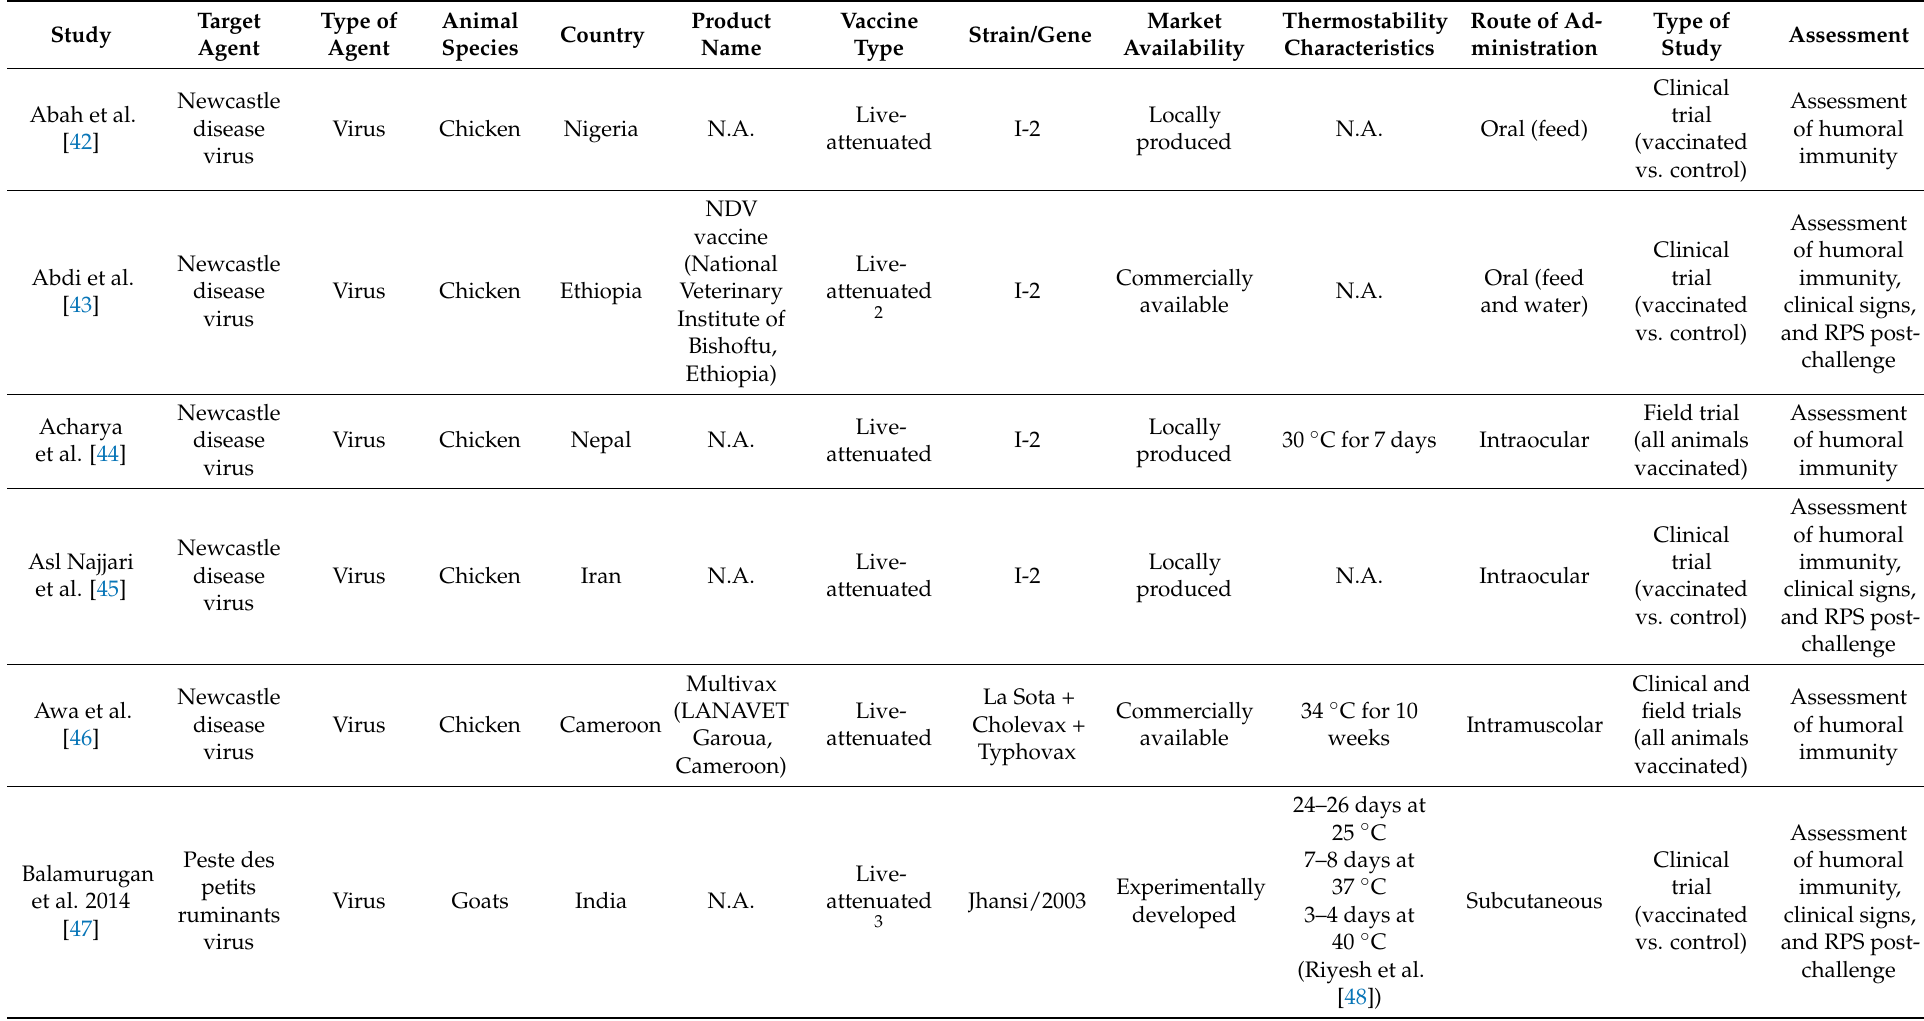
Table 2. Overview of the studies included in the qualitative synthesis retrieved from the broad search on thermostable